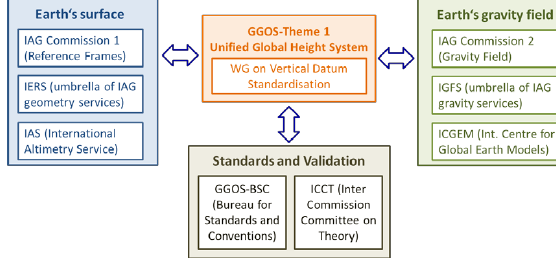
Figure 8. Interaction of the working group on Vertical Datum Stan- dardisation with other GGOS/IAG components.